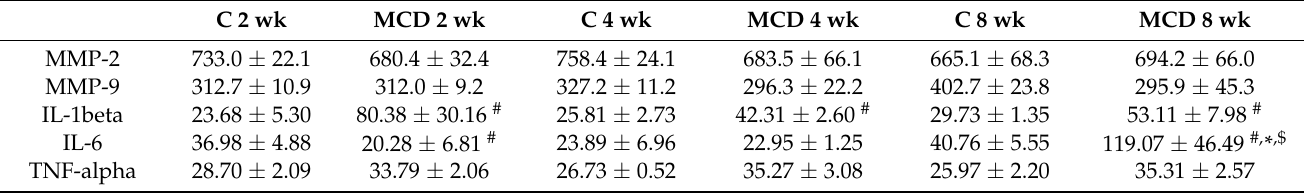
Table 5. Changes in serum MMPs, IL-1beta, IL-6 and TNF-alpha using rats fed with MCD diet for 2-, 4- and